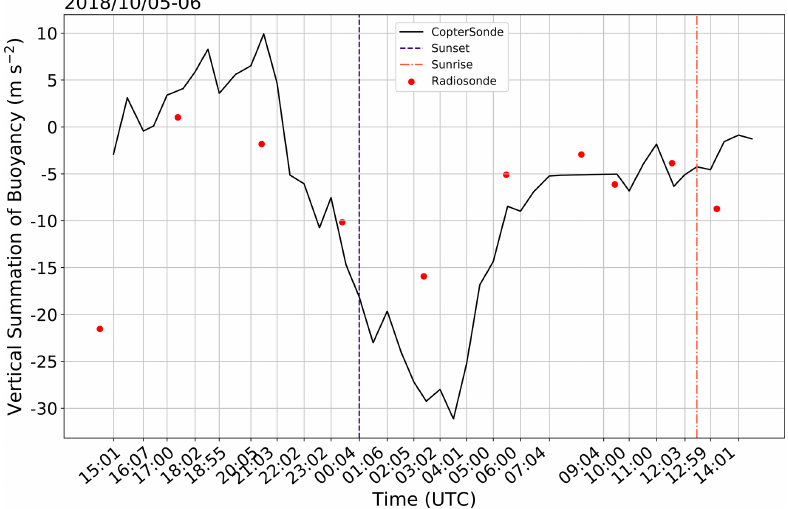
Figure 6. Time series of vertically summed buoyancy (ms − 2 ) on 5–6 October 2018. The black line is the CopterSonde data, and red dots are the radiosonde data. Purple and orange vertical lines represent sunset and sunrise, respectively.